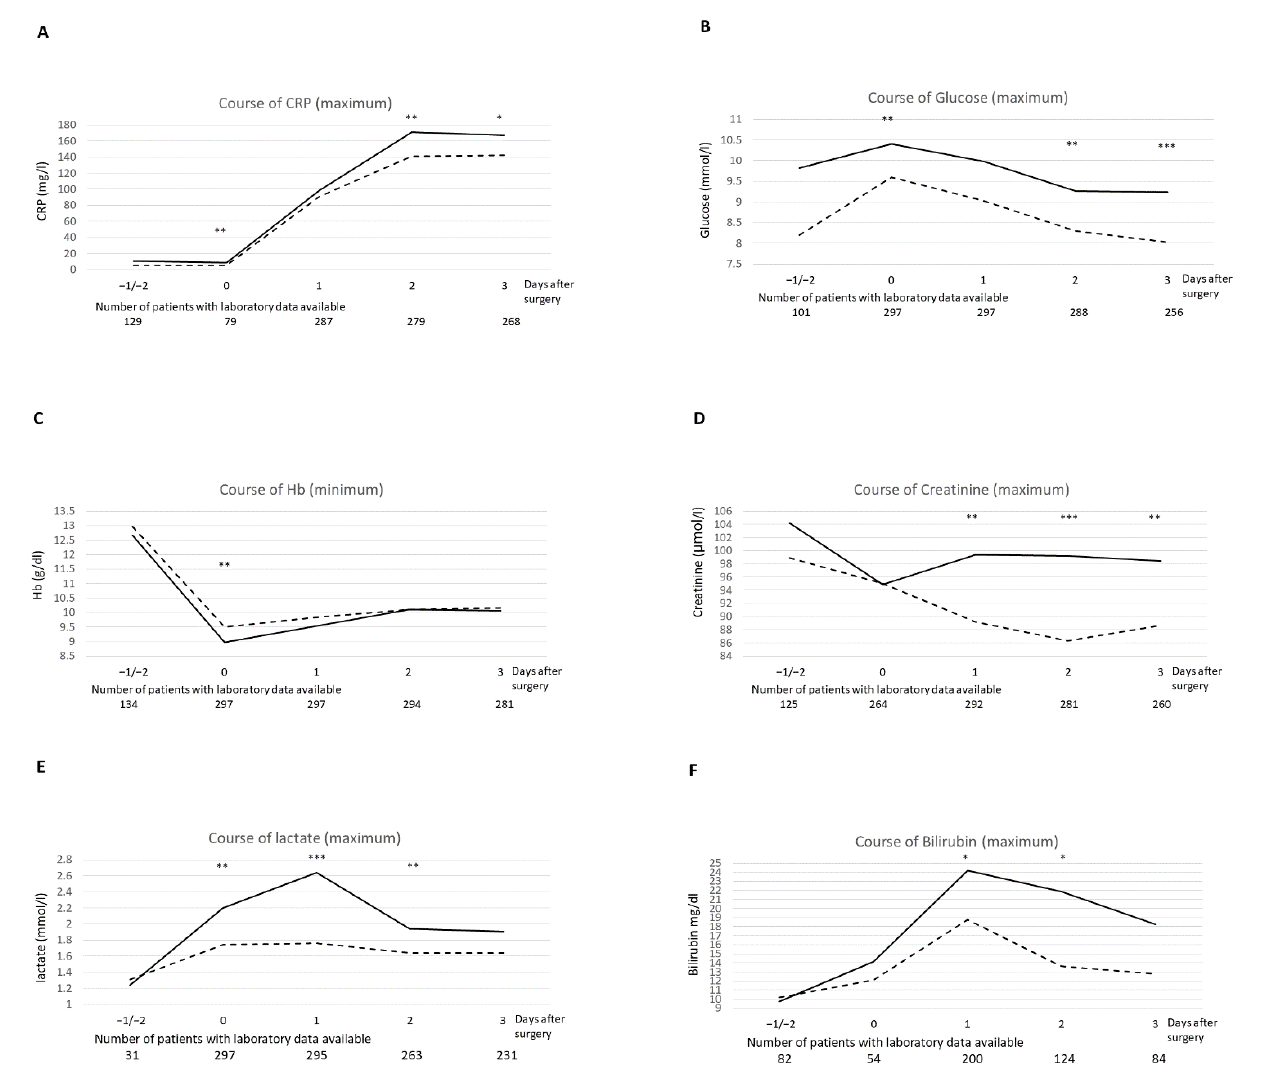
Figure 2. Perioperative course of biochemical markers in patients with or without neurologic complications. Legend: Temporal pattern of relevant laboratory values: CRP ( A ), Glucose ( B ), Hb ( C ), Creatinine ( D ), Lactate ( E ), Bilirubin ( F ), time points: − 1 = prior to surgery, 0 = during